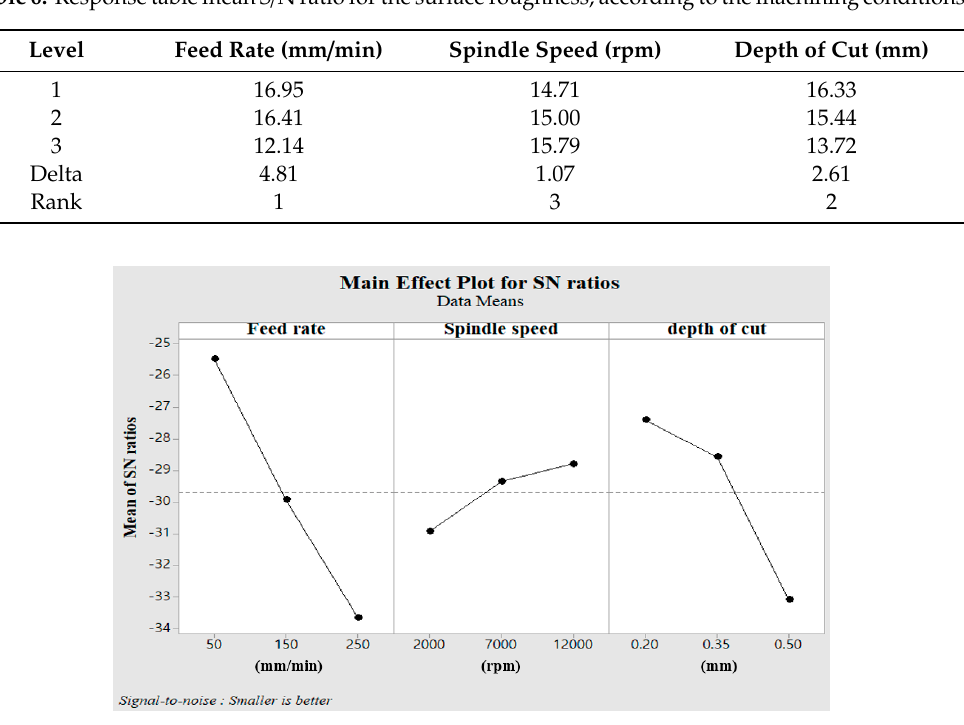
2 Table 6. Response table mean S/N ratio for the surface roughness, according to the machining conditions. Level